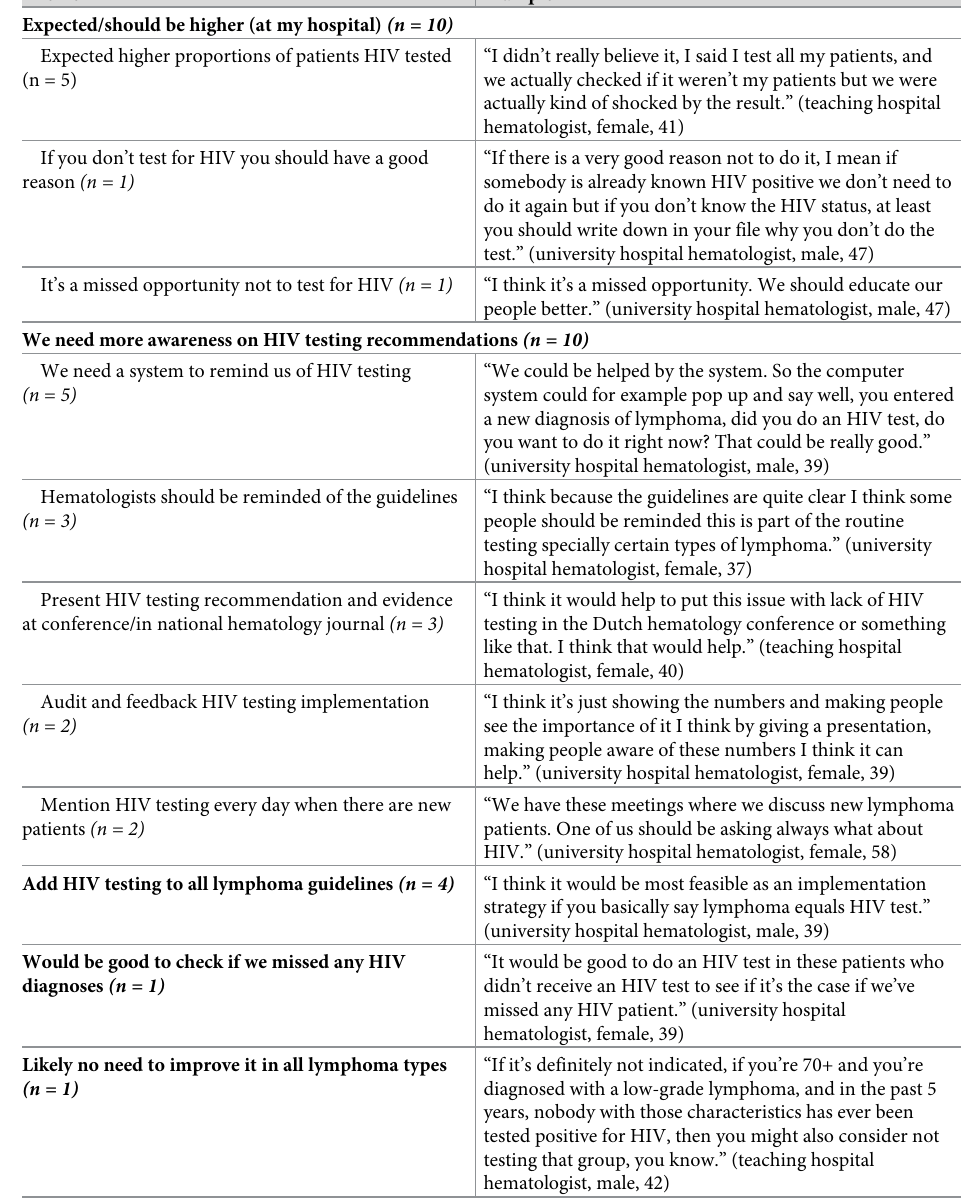
Table 3. Hematologists’ reflections on HIV testing among patients with malignant lymphoma and recommenda- tions for improvement.